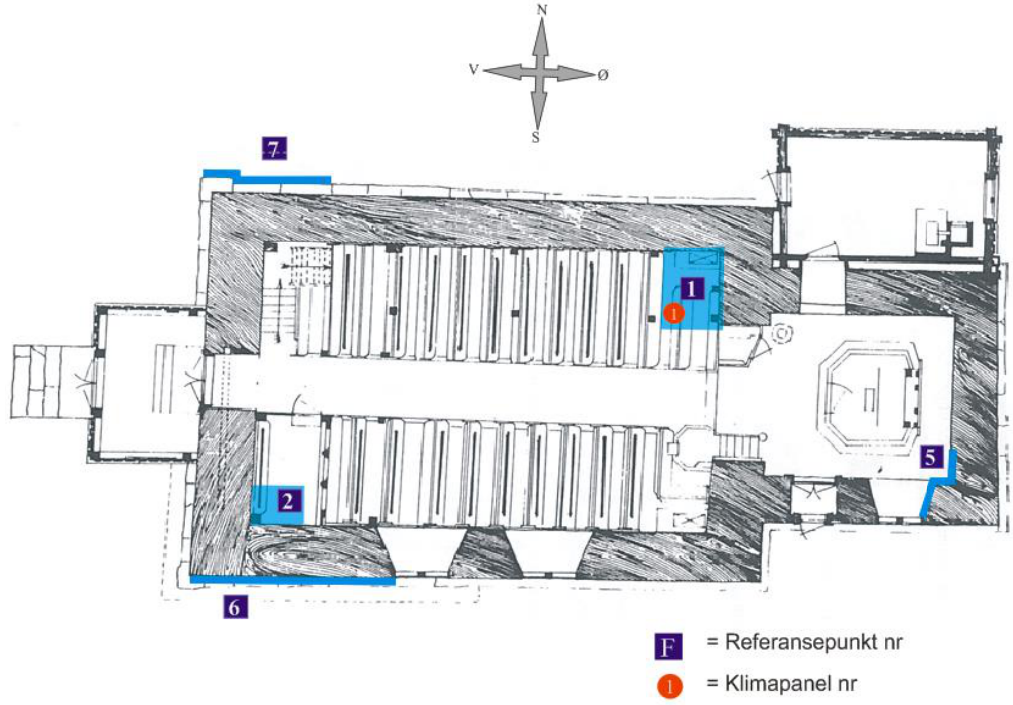
Figure 2. Positions of climate panels (red dot) and reference points (blue squares) in Skoger Old Church.